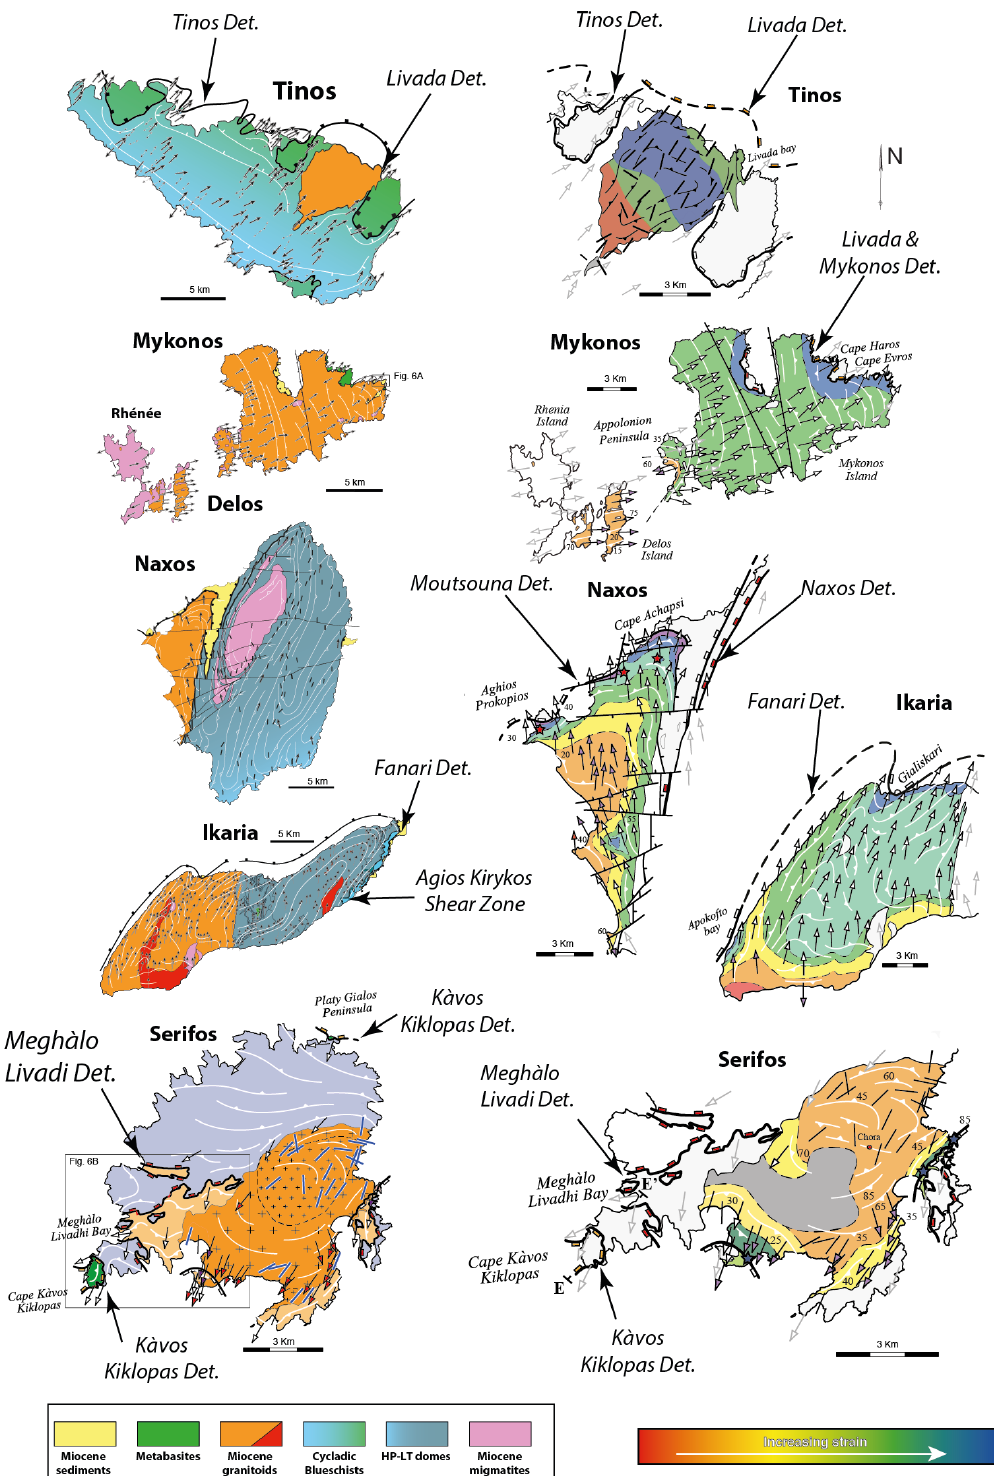
Figure 5. Five examples of the Aegean granitoids showing the interactions between deformation and intrusion, after Rabillard et al. (2018) and references therein. Maps of the left column show maps of the entire islands, and the right column shows the internal fabrics of the plutons. These maps were obtained based on deformation grades observed in the field; a scale of grades was designed for each pluton to describe the gradients. Arrows show stretching lineations and the sense of shear, and black bars on the Tinos pluton show the direction of the magnetic